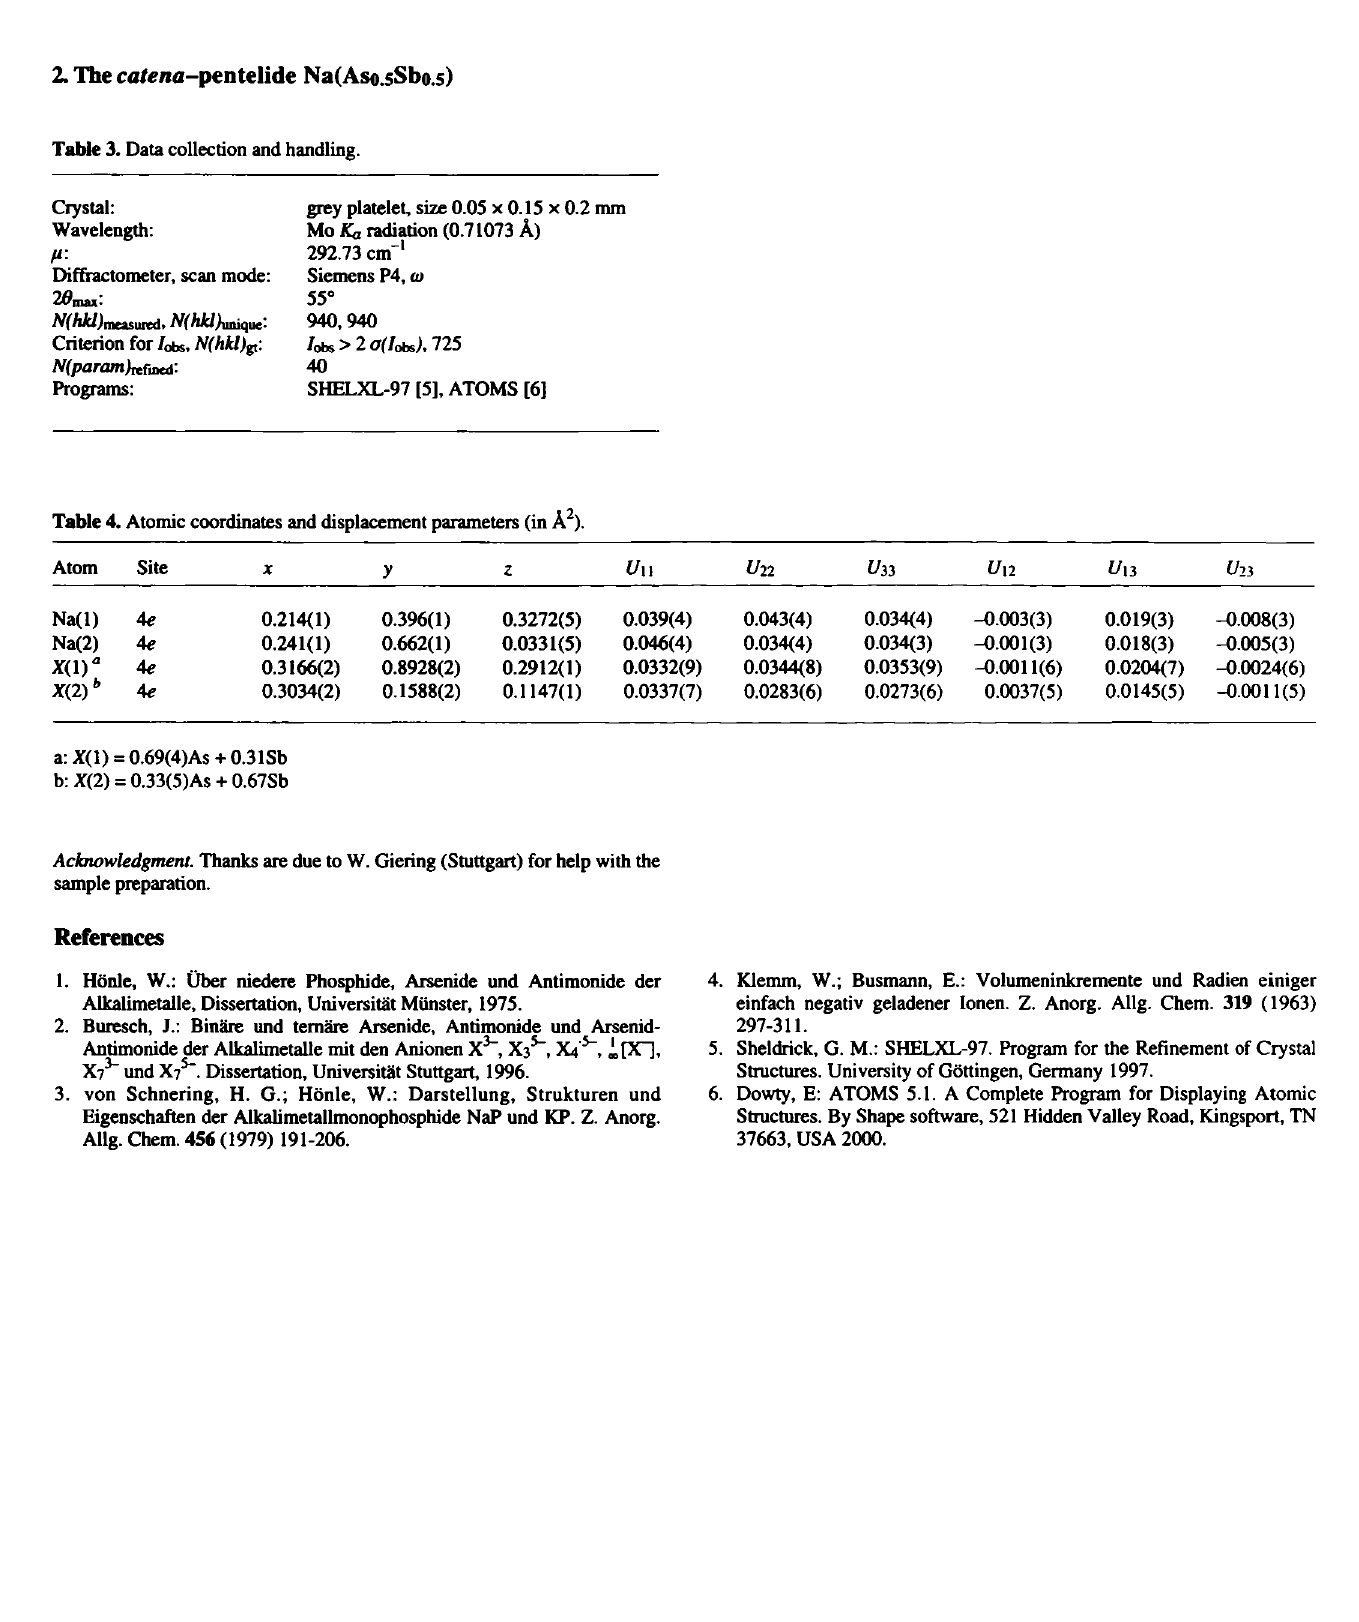
Table 3. Data collection and handling.